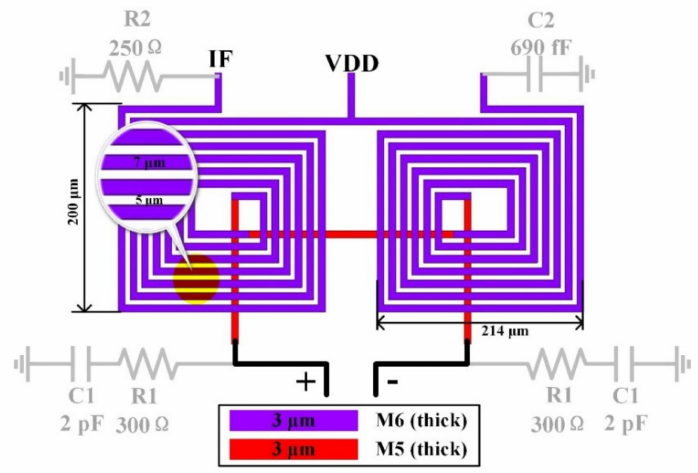
Figure 12. Marchand-balun-based matching network and detailed parameters of IF output